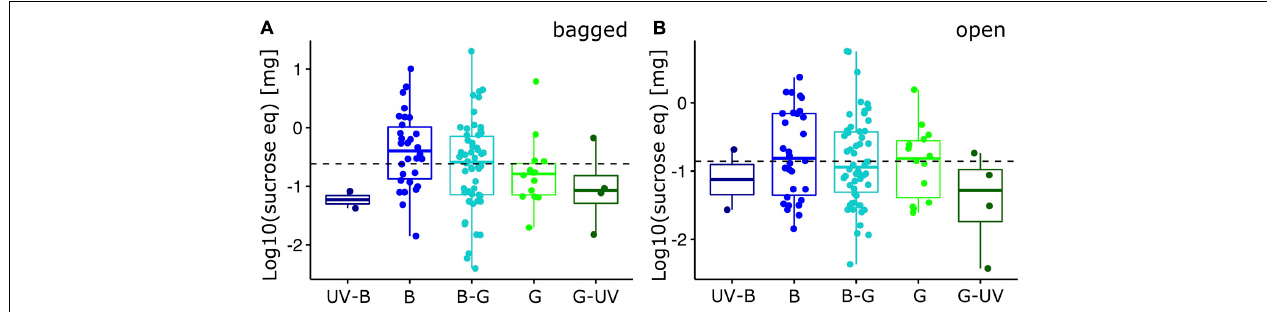
FIGURE 4 | Nectar standing crop of alpine flowering plants (inflorescences). Log10-transformed maximum reward quantity, expressed as mg sucrose equivalent per inflorescence for bumble bee visited plant species ( N = 105). Reward quantity was measured for (A) bagged inflorescences and (B) and open inflorescences. Box-plots indicate the median (line) and interquartile range (IQR, i.e., Q25-Q75; box). Lower and upper whiskers indicate Q25-1.5*IQR and Q75+1.5*IQR, respectively. The horizontal dashed line indicates the overall mean. Individual data points have been added with random X -axis jitter. X -axis categories are the five hexagon categories used in the analysis (see Figure 1 ; UV-B, UV-blue; B, blue; B-G, blue-green; G, green; G-UV, green-UV). For statistics, see text.